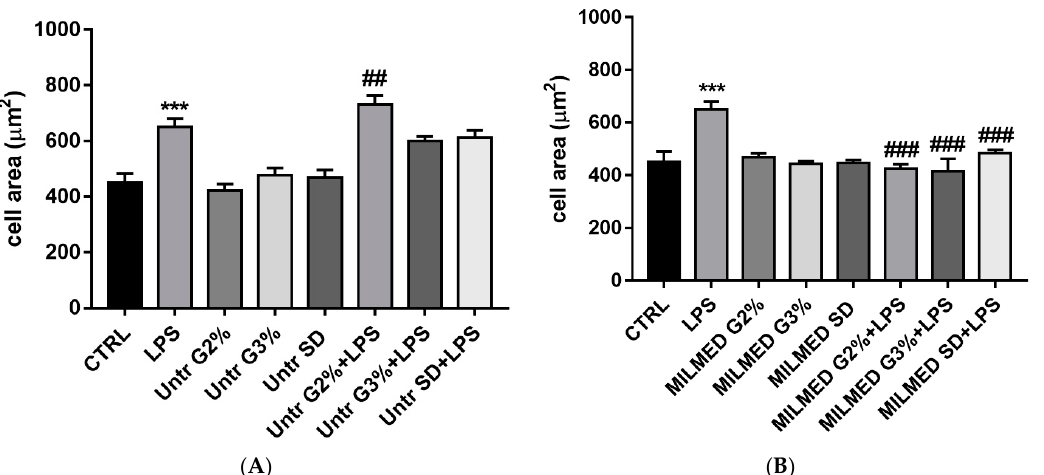
Figure 1. ( A ) BV2 cells area following Lipopolysaccharide (LPS) treatment (1 ng/mL) for 24 h